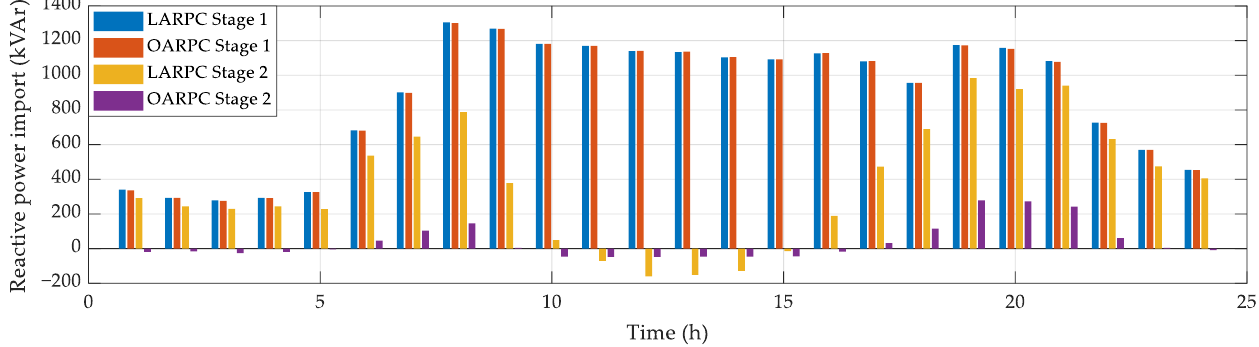
Figure 13. Reactive power import profile comparison for both stages of OARPC and LARPC.